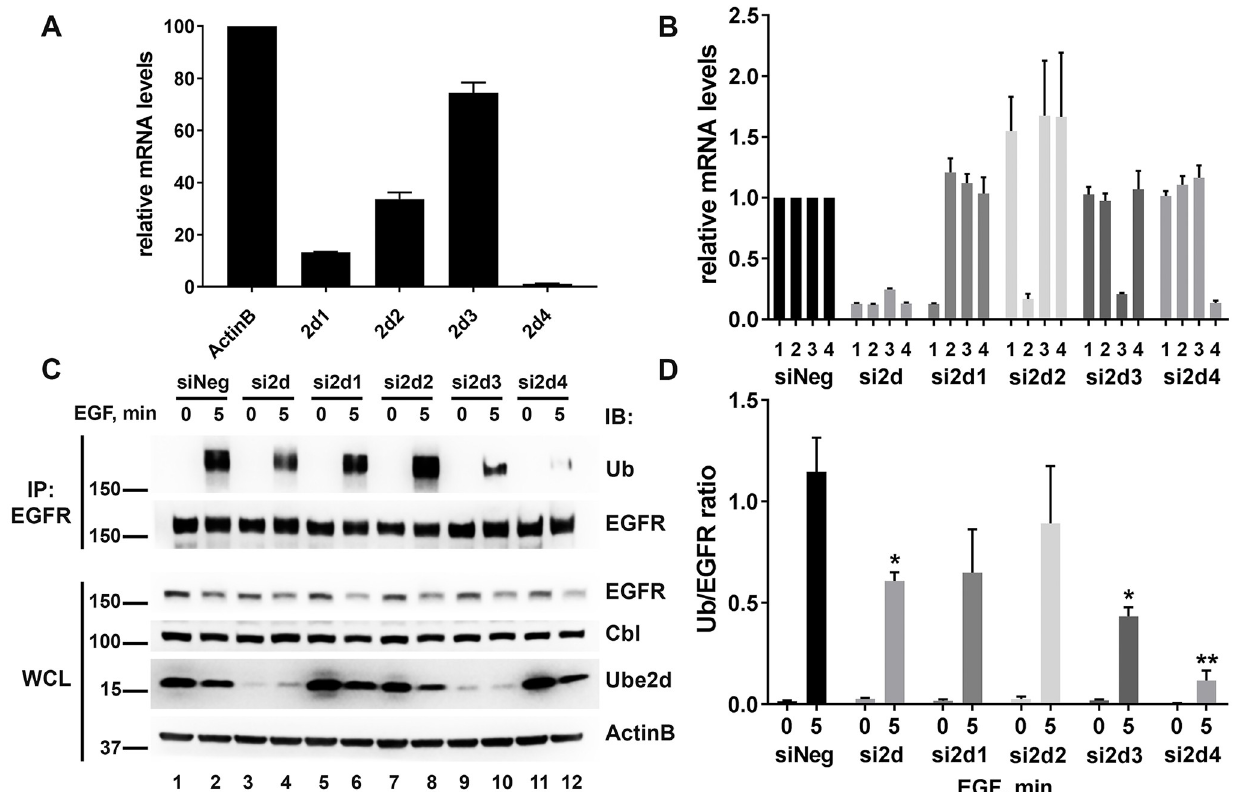
Fig 6. Knockdown of Ube2d proteins decreases ubiquitination of EGFR in HeLa cells. HeLa cells were transfected with control siRNA (siNeg), or siRNAs targeting Ube2d1, Ube2d2, Ube2d3 and Ube2d4 separately or together (si2d) for 48 hours and then were either left untreated (0) or treated with 25 ng/mL EGF for 5 minutes (5). (A) RT-QPCR analysis of Ube2d mRNA expression as compared to ActinB expression in HeLa cells transfected with siNeg averaged for four independent transfections ± SEM. (B) RT-QPCR analysis of Ube2d knockdown efficiency in transfected HeLa cells. Numbers 1 through 4 on the X axis indicate the primers to Ube2d1 through Ube2d4, respectively, used in the PCR reaction. Average for three independent experiments ± SEM is shown. (C) Immunoblot analysis of whole cell lysates (WCL) using antibodies to detect EGFR, Cbl, all members of Ube2d family, and ActinB. EGFR was immunoprecipitated from the lysates and blotted for ubiquitin (Ub) or EGFR as indicated. (D) The fraction of ubiquitinated EGFR was calculated by densitometry analysis of EGFR IP from three independent experiments and plotted as an average ratio of Ub/EGFR ± SEM. Asterisk ( � ) denotes p < 0.05, ( �� ) denotes p < 0.01. MW in kDa is shown to the left of the WB